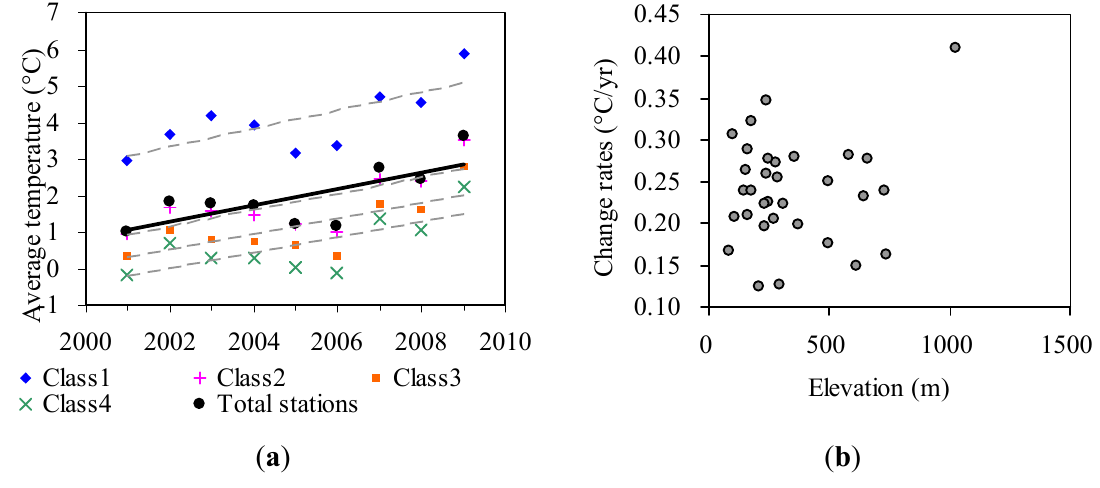
Figure 3. ( a ) Trends of average annual temperature during 2001–2009, ( b ) and the relations with elevation over 32 climate stations. The regression lines of temperature on year have been superimposed in